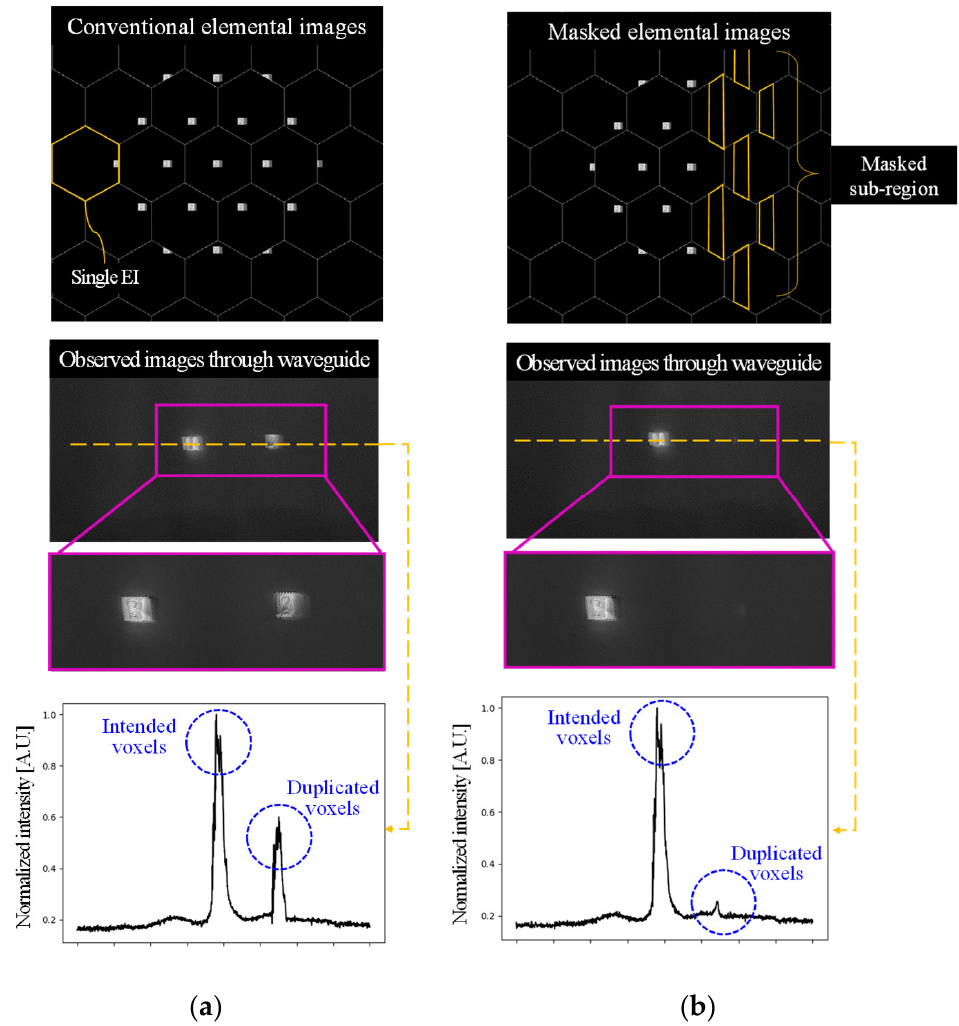
Figure 8. Preliminary experiments using the small dice object: we generated the EIs for the virtual depth of 400 mm ( a ) without, and ( b ) with applying the proposed method to solve the voxel duplication problem. The observed images through the holographic waveguide were captured, and the normalized intensity profiles along the dashed line at the center row of captured images are presented in the lower parts of the figure.